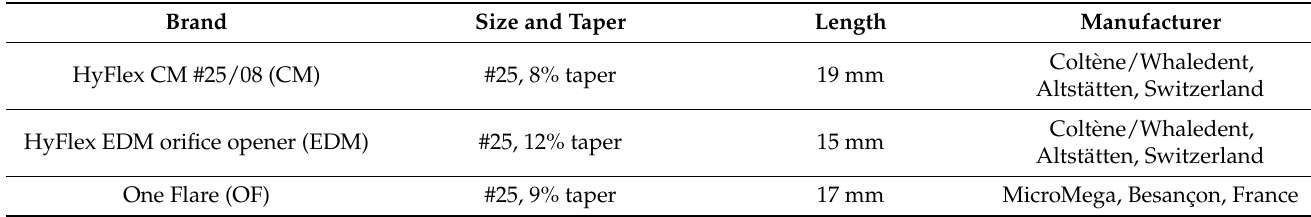
Table 1. Specifications of tested